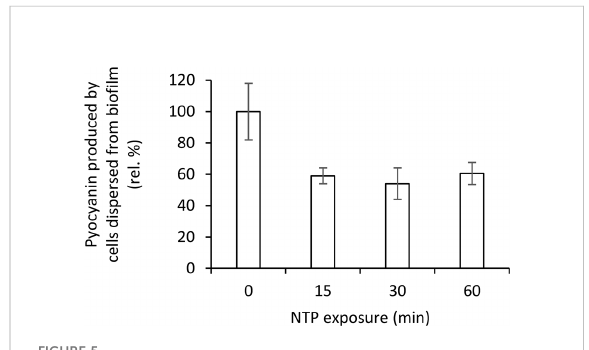
FIGURE 5 Effect of NTP treatment on pyocyanin production by cells dispersed from bio fi lm of Pseudomonas aeruginosa ATCC 10145 determined by pyocyanin extraction.